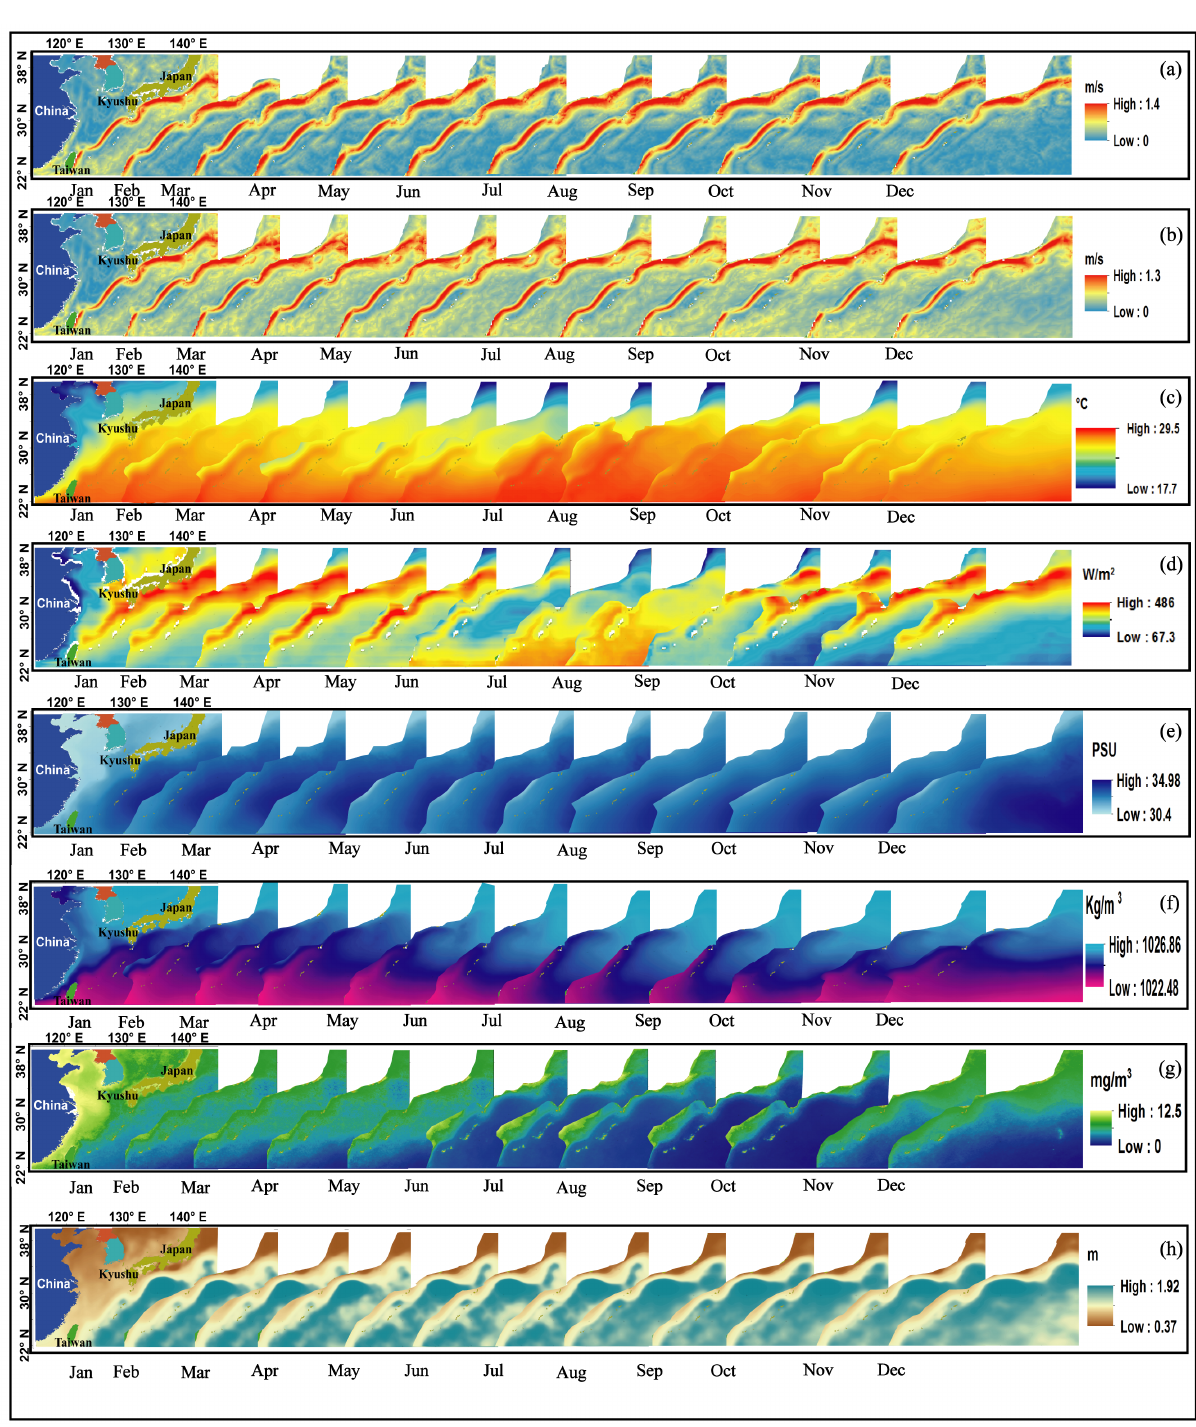
Figure 6. Synoptic view of data ( a ) Argo; ( b ) Sea Surface Current; ( c ) SST; ( d ) Heat Flux; ( e ) SSS; ( f ) SSD; ( g ) Chlorophyll- α ; and ( h ) SSH illustrating entire KC by applying simple spatial filters . Finally, the synoptic composition of the whole procedure applied for all the selected datasets and all months, especially for March, is illustrated in Figure 2. The Kuroshio extent and its centerline from monthly climatology data of sea surface current at 0 m between 1993 and 2018 (Figure 8a). The Kuroshio extent from their respective parameters used to extract the climatological Kuroshio as a polygon zone for March as shown in Figure 8b, whereas, in previous studies, KC was studied as a rectangular region or as a line